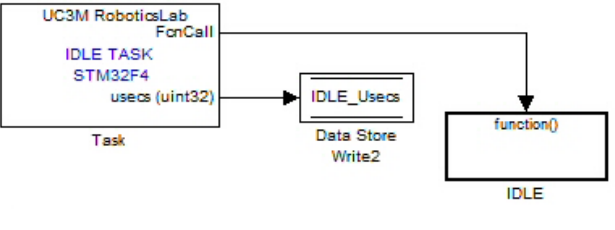
Figure 7. The idle task block enables the usage of the available free time of the MCU; this block continuously executes the connected subsystem when the higher preemptive priority task ends.